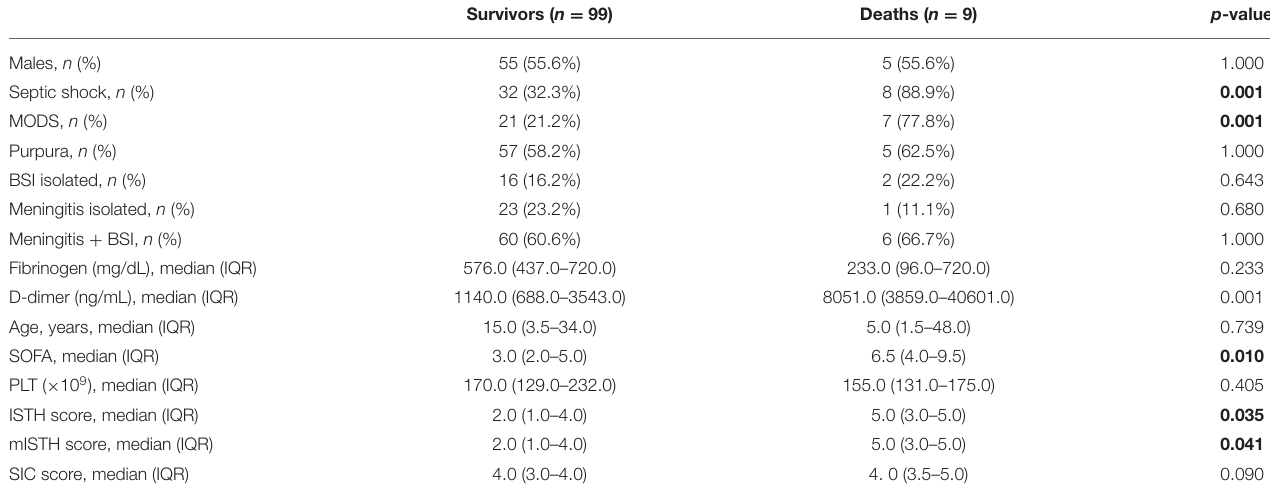
TABLE 4 | Neisseria meningitidis .